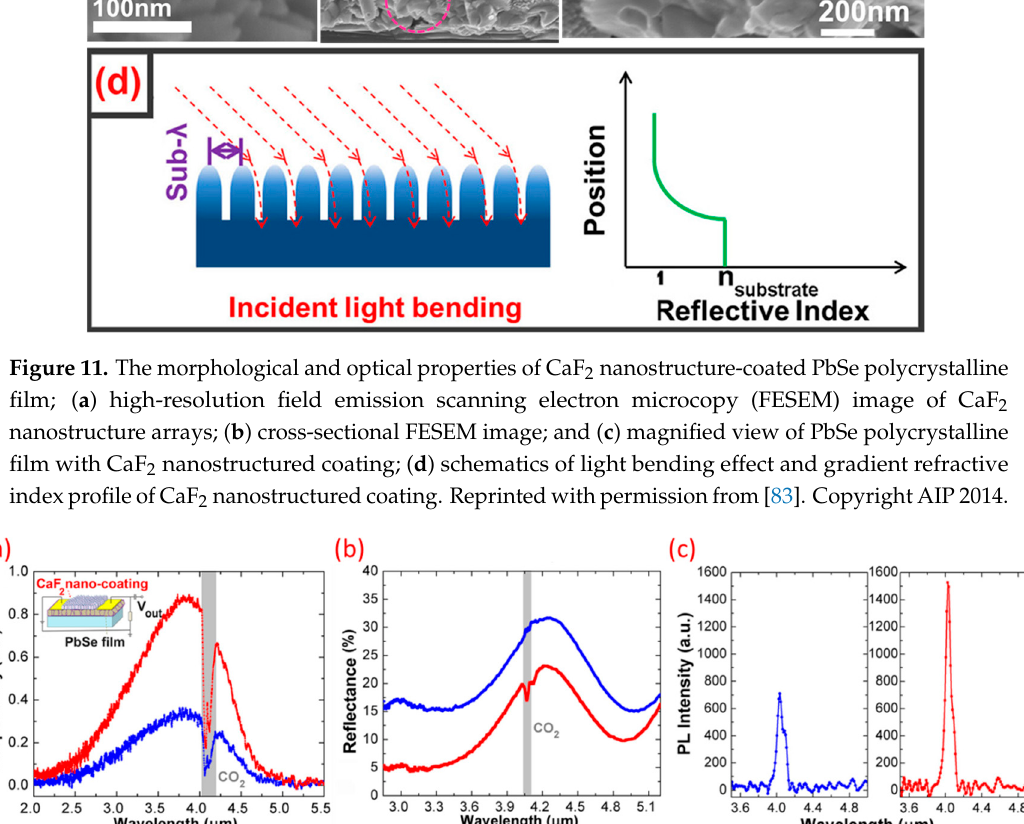
Figure 12. Comparisons of the ( a ) responsivity; ( b ) reflectance; and ( c ) PL spectra of PbSe polycrystalline film with and without CaF 2 nanostructured coating. Reprinted with permission from [83]. Copyright AIP 2014.